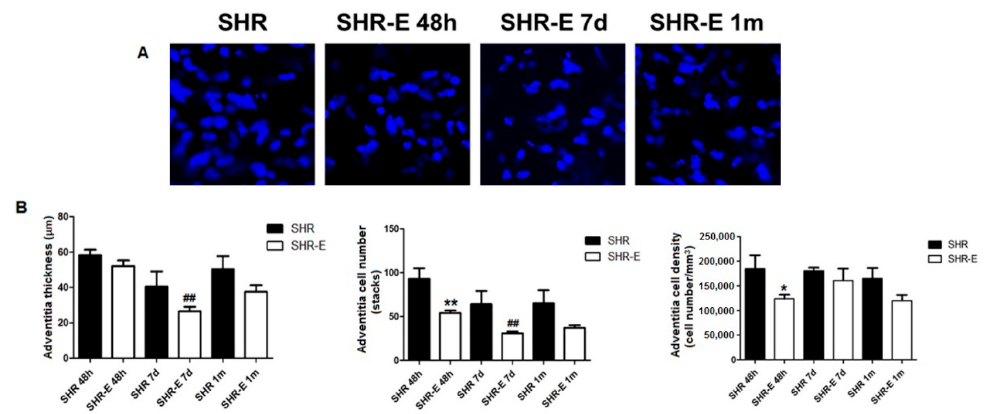
Figure 4. Adventitial layer of the left anterior descending coronary artery. Shown are cell nuclei (confocal microscopy images, × 20, zoom 8) ( A ) and the composition of the adventitial layer ( B ) of the coronary artery in treatment groups (48 h) and withdrawal groups (7 days and 1 month). SHRs, rats treated with vehicle; SHR-Es, rats treated with esmolol; n = 9 rats for each experimental group. Values are mean ± SEM. * p < 0.05, ** p < 0.01 vs. SHRs, ## p < 0.01 vs. SHR-E 48 h group.